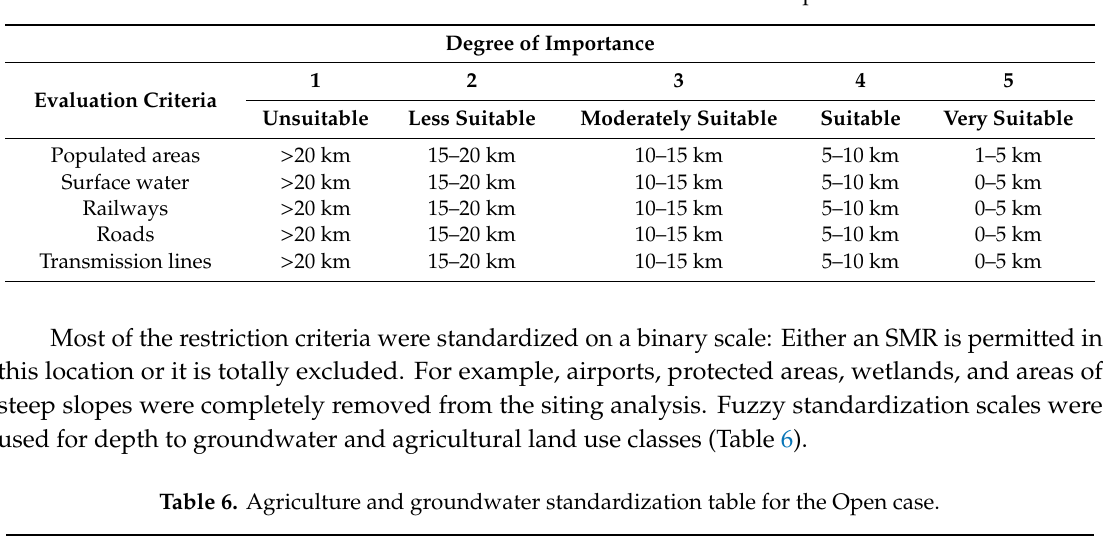
Table 5. Evaluation criteria standardization values for the Open case.